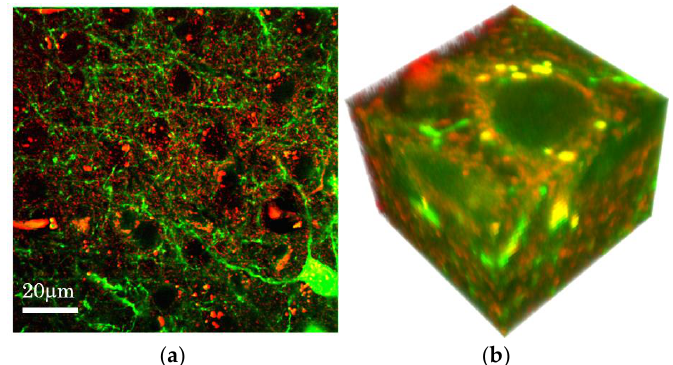
Figure 8. Simultaneous photothermal (red) and fluorescence (green) imaging of a slice of mouse brain. The wavelengths of pump and probe beams were 405 nm and 640 nm, respectively. ( b ) Reconstructed 3D model of PT signal in cortex. Image size is 19.1 × 19.1 × 15.7 μm 3 .